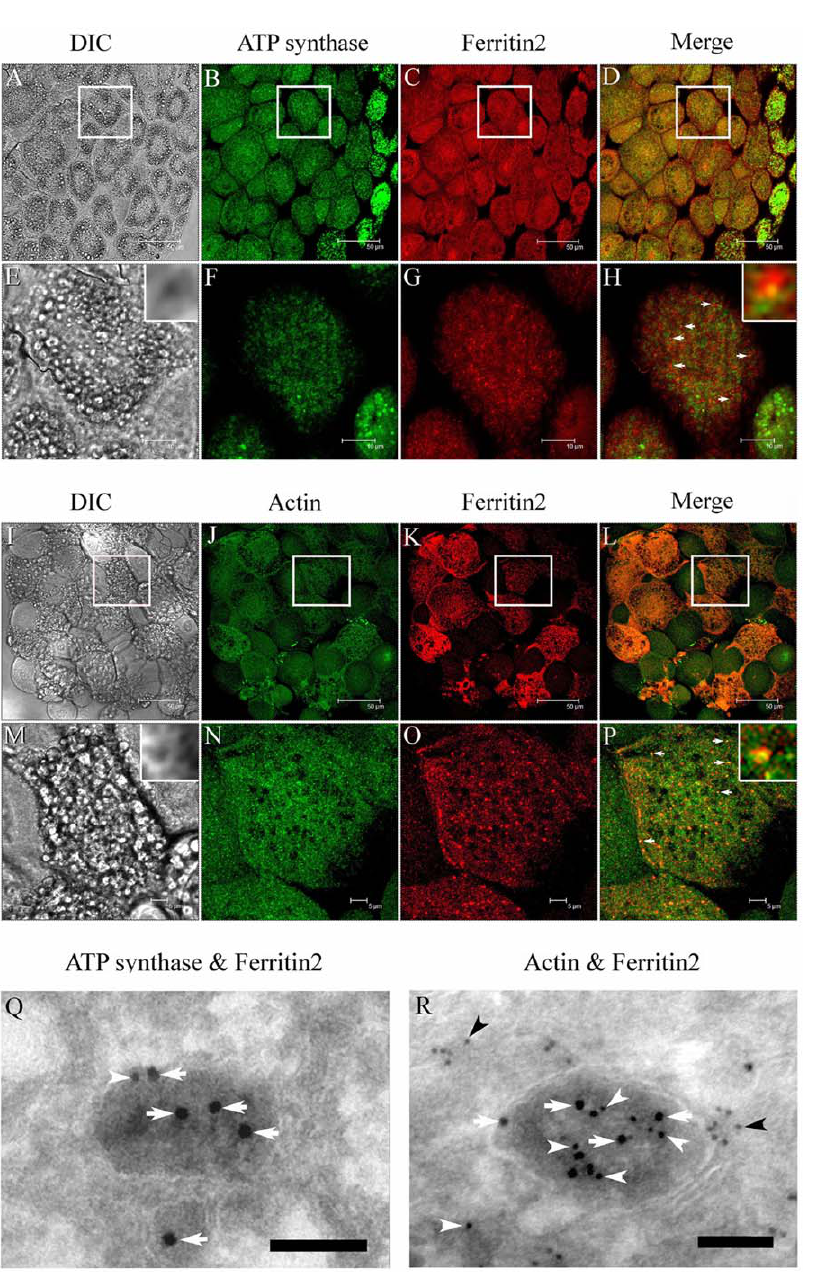
Figure 3. Double labeling assay of ATP synthase, ferritin 2, and actin. (A–D) ATP synthase and ferritin 2 were doubly stained and detected in IDVs (arrows) by CM. Scale bar, 50 m m. (E–H) Images enlarged from the boxed area of A–D. Scale bar, 5 m m. Insets show magnified micrographs. (I–L) Actin and ferritin 2 were doubly stained and detected in IDVs (arrows) by CM. Scale bar, 50 m m. (M–P) Images enlarged from the boxed area of I–L. Scale bar, 5 m m. Insets show magnified micrographs. (Q) Double labeling assay for detecting ATP synthase (arrowhead) and ferritin 2 (arrows) in IDVs by TEM. Scale bar, 100 nm. (R) Double labeling assay for detecting actin (arrowheads) and ferritin 2 (arrows) in IDVs by TEM. Scale bar, 100 nm.